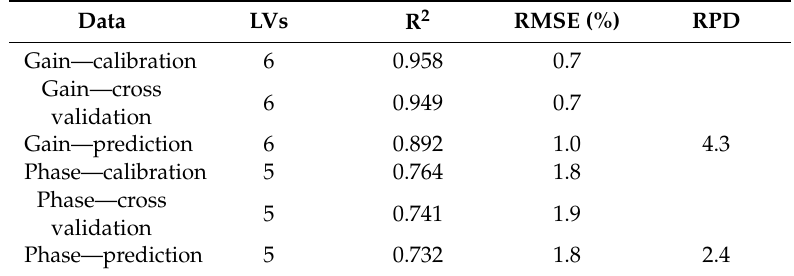
Table 2. Partial least squares (PLS) regression models for the prediction of soil moisture content (%) from “gain” and “phase” spectra. RMSE, root mean square error; RPD, residual prediction deviation; LV, latent variable.